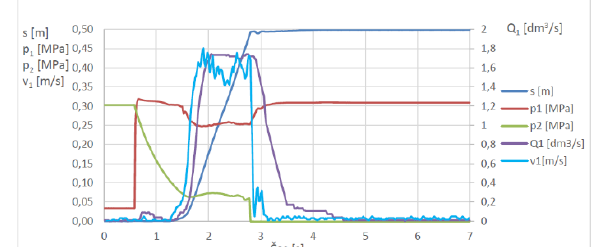
Fig. 6. Graph of measured data for extension of piston rod, for working pressure 0.3 𝑀𝑃𝑎